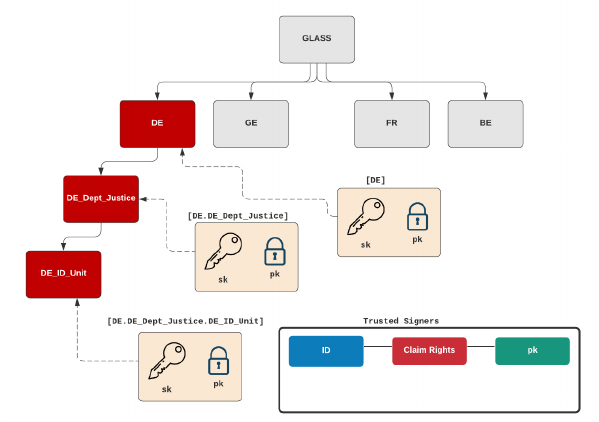
Figure 4. Overview of the trust